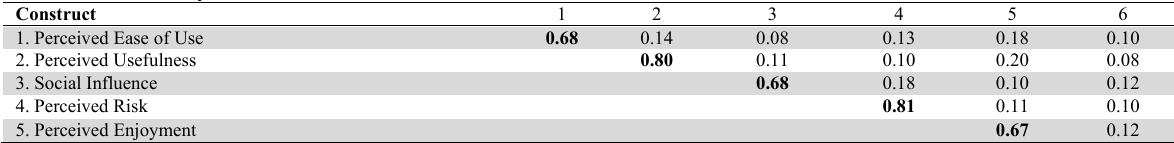
Discriminant Validity